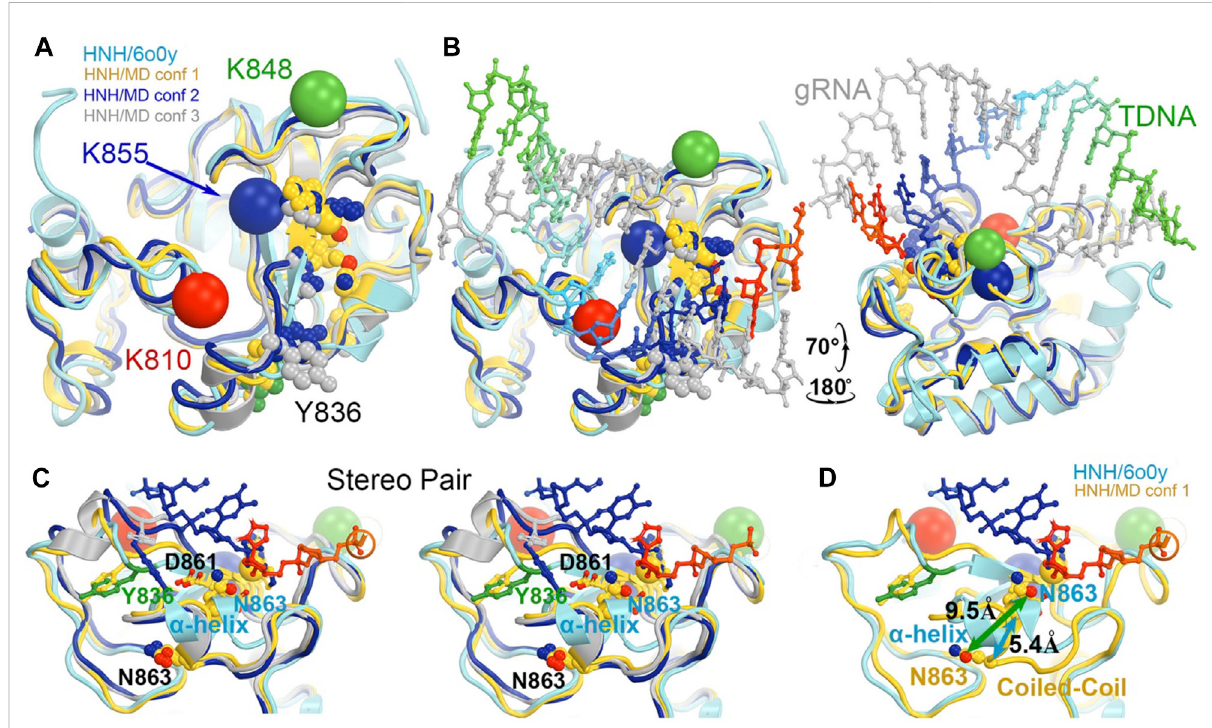
FIGURE 9 Potential roles of three MD-derived HNH conformations during activation of the HNH active site. (A) Alignment of the three MD-derived conformations of the HNH domain (gold, blue, and silver for conformations 1, 2, and 3, respectively) superimposed onto the 6o0y experimental structure (cyan). Locations of three Lys-to-Ala mutations are shown in large spheres at C α : K810, red, K848, green, and K855, blue. Metal ion is in medium-size gold sphere. Y836, D861, N863, and H840 residues are shown. (B) Two views of the superposition in the presence of the RNA/ DNA duplex. (C) Stereodiagram of a close-up view for showing the relationship of the Y836/D861/N863 three residues (B) . (D) A conversion of coiled-coil to α -helix results in a large displacement of N863 (5.4 Å at C α and 9.5 Å at O ε 1). See Supplementary Video S2 for locations of three mutants relative to domain